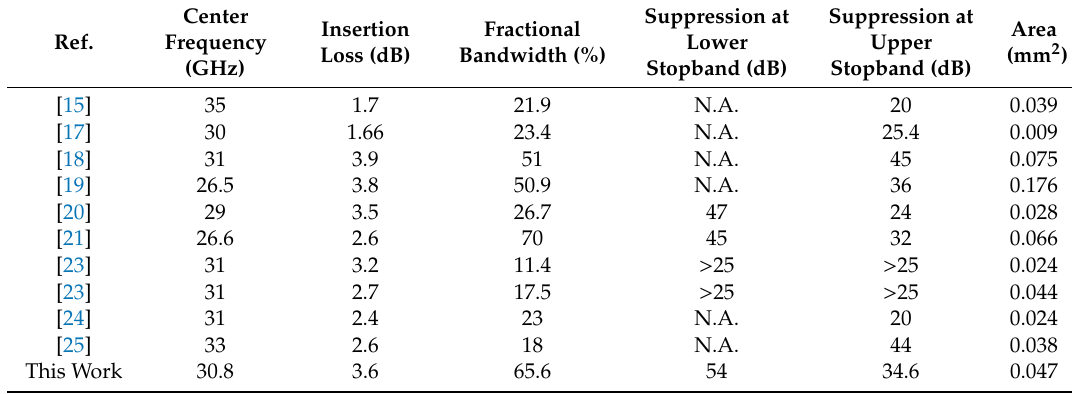
Table 1. Performance summary and comparison with other published works.